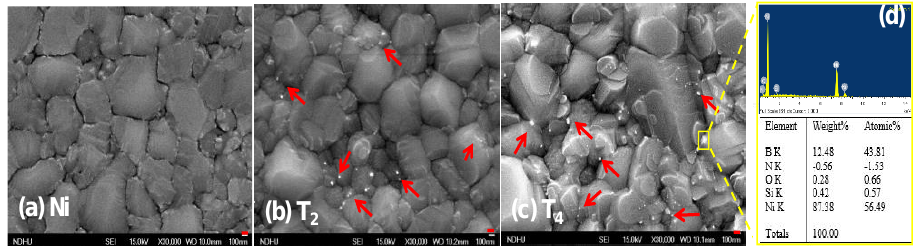
Figure 3. FE-SEM images, ( a ) Ni Substrate, ( b ) T 2 (700/1300 °C), ( c ) T 4 (800/1300 °C), and ( d ) EDS analysis of T 4 .